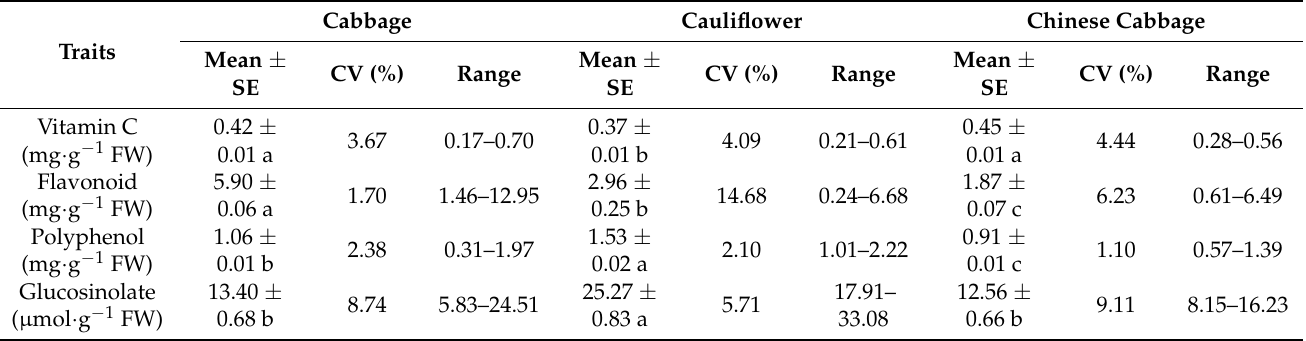
Table 5. Mean ± standard error (SE), range, and coefficients of variation (CVs) for the antioxidant traits in the species analyzed. Species means with different letters are significantly different at p ≤ 0.05.